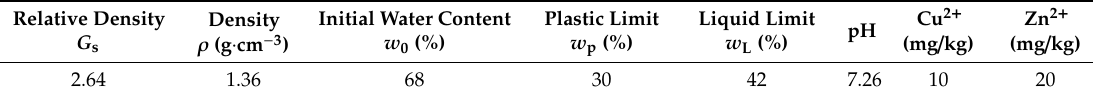
Table 1. Properties of remolded soil.